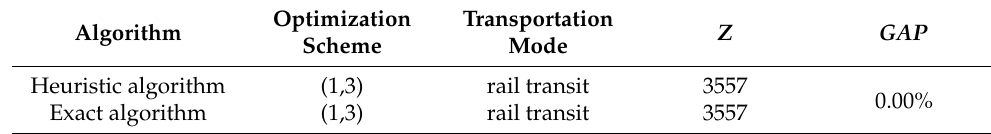
Table 7. Comparison between the heuristic algorithm and the exact